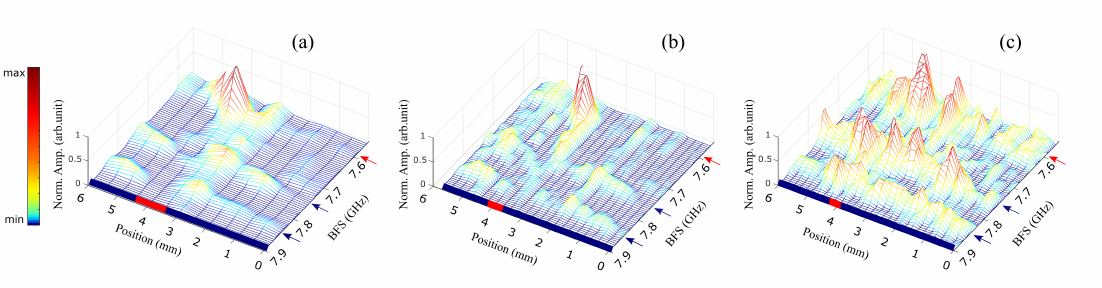
Figure 13. Detection of a ( a ) 1-mm, ( b ) 500- µ m, and ( c ) 200- µ m longitudinal feature in silicon- chalcogenide waveguides